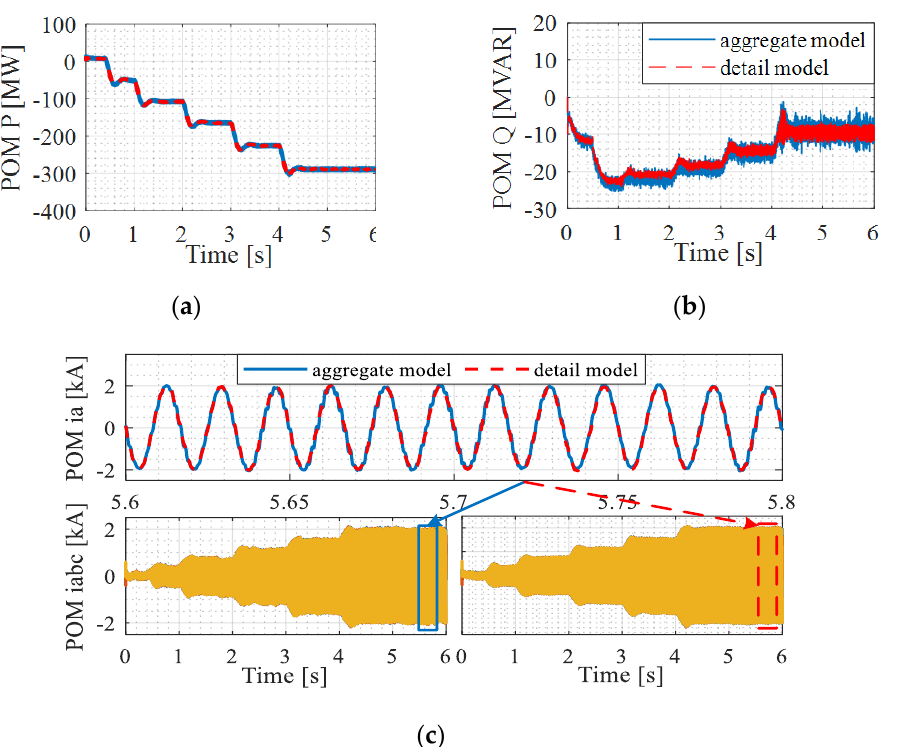
Figure 14. Active and reactive power and current at the POM for Case 4 using aggregated and detailed models: ( a ) Active power, ( b ) Reactive Power, ( c ) Three-phase current plus a comparison of Phase a current.